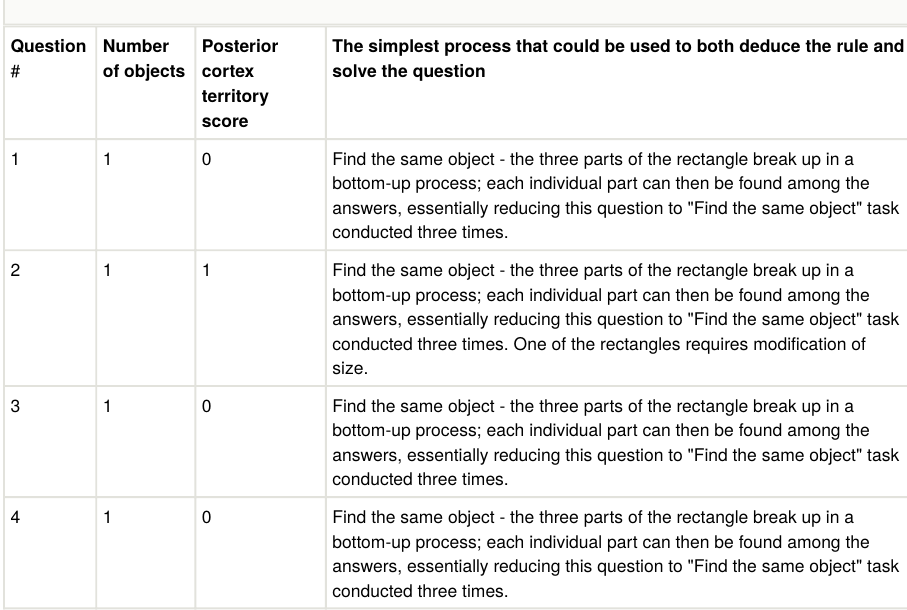
Panel assignment of mental processes for WISC-V, Visual